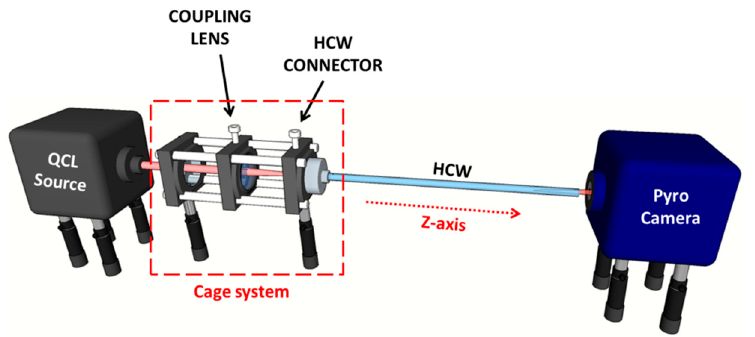
Figure 2. Schematic of the experimental setup used to optically couple quantum cascade laser (QCL) sources and the HCWs. A ZnSe lens is used to focus the collimated beam exiting from the QCL onto the waveguide entrance. An infrared pyrocamera detects the profile of the beam exiting from the HCW.